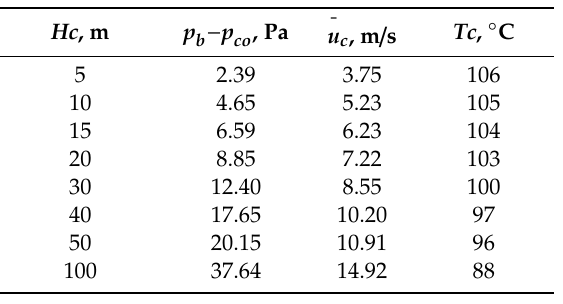
Table 1. The air parameters in the chimney for To = 26 ◦ C, h = 0.1 m, R = 10 m, Rc = 0.2 m, α = 10 W / (m 2 K).